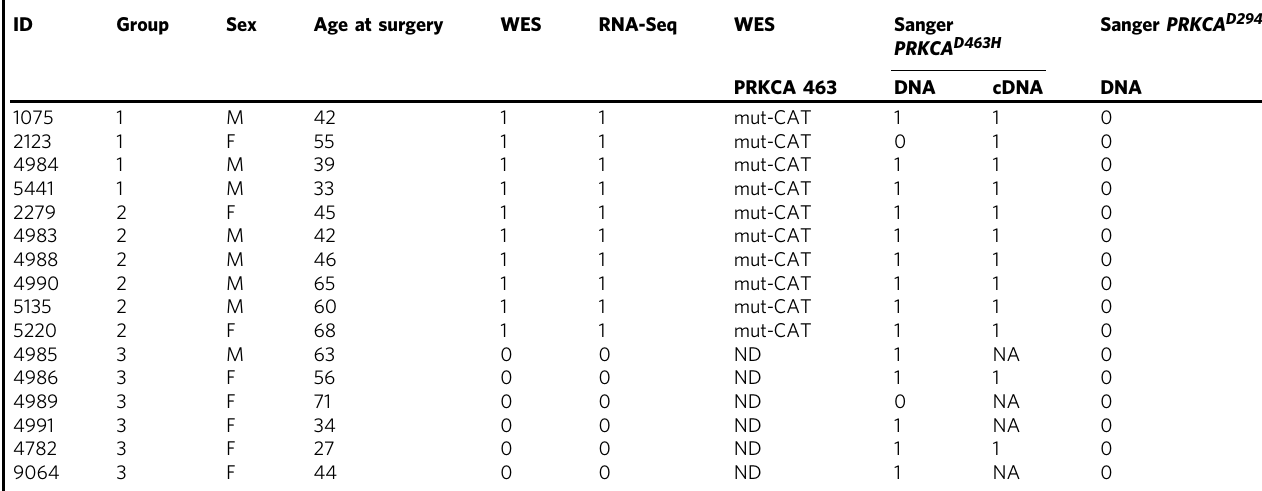
Table 1 Clinical and genetic feature of the 16 patients with ChG ID